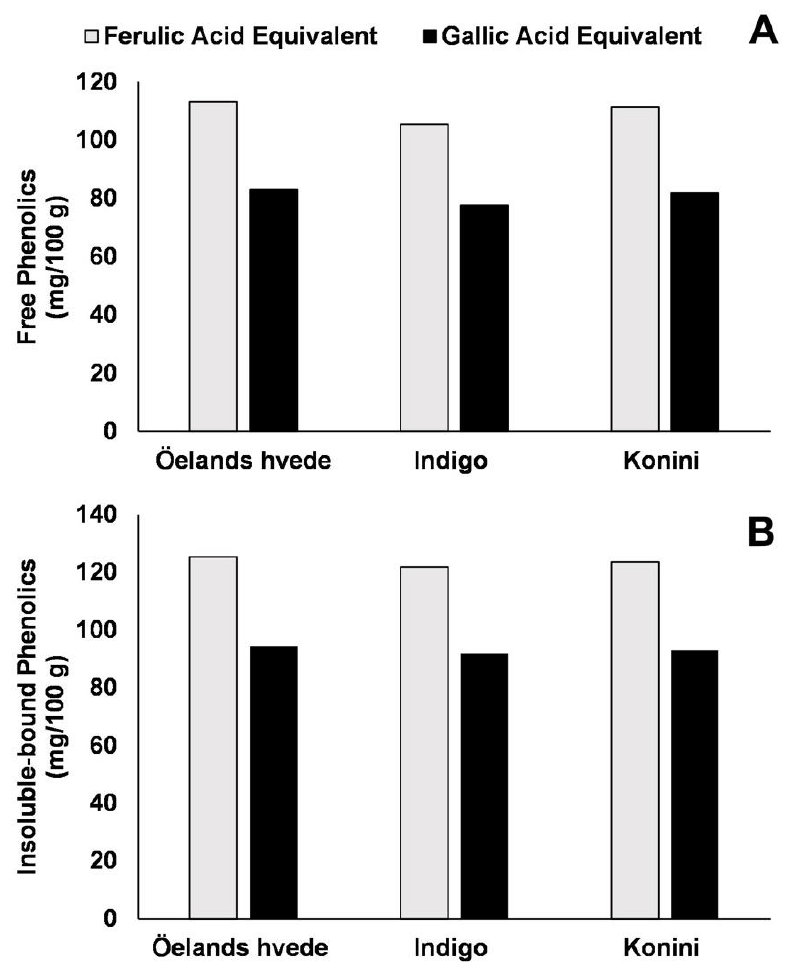
Figure 1. Total phenolic content of free ( A ) and insoluble-bound ( B ) fractions of wheat flour from common and purple wheat grains. Adapted from Yu and Beta [96].